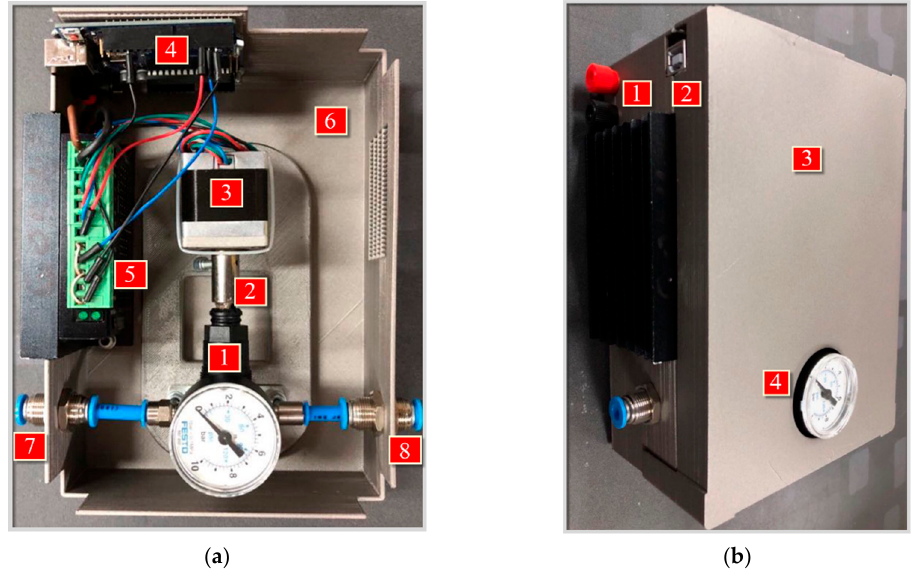
Figure 4. Automatically controlled pressure regulator ( a ) without the cover: (1) Pressure regulator, (2) Coupling, (3) Stepper motor, (4) Microcontroller, (5) Motor driver, (6) Plastic housing, (7) Compressed air inlet, and (8) Outlet connector ( b ) with the cover: (1) Power supply connector, (2) Microcontroller port, (3) Plastic cover, and (4) Hole for the pressure regulator. Reproduced from [4], Springer: in press.